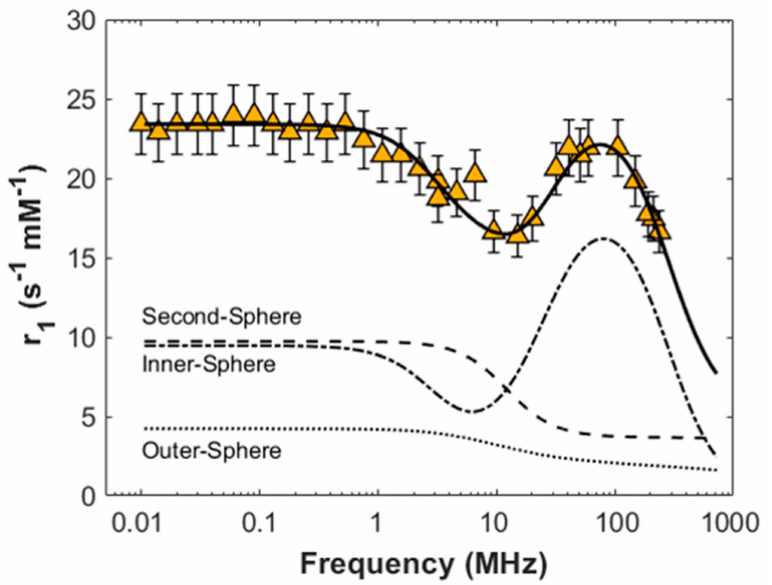
Figure 8. Fit of the r 1 NMRD profile data with the SBM model equations. The different contributions to the longitudinal relaxivity (inner-, second- and outer-sphere) are also highlighted. Best fit parame- ters: q = 1 (fixed), r = 3.0 Å (fixed), τ r = 0.66 ± 0.05 ns, τ m = 254 ± 38 ns, q’ = 5.8 ± 0.2, r’ = 3.2 ± 0.1 Å, τ m ’ = 26 ± 5 ps, ∆ = 0.040 ± 0.004 cm − 1 , τ v = 15 ± 2 ps. The following assumptions were made: q = 1, r = 3.0 Å, d = 3.5 Å and D = 2.3 × 10 − 9 m 2 s − 1